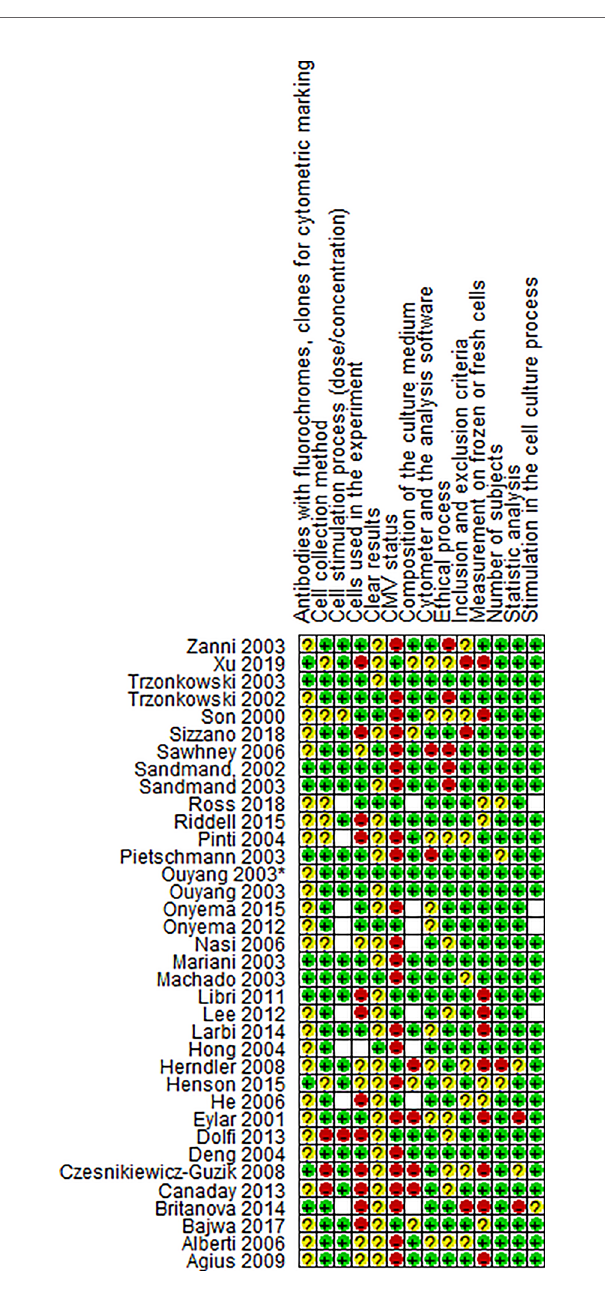
FIGURE 3 | Risk of bias summary for paper. Review authors ’ s judgments about each risk of bias item for each included